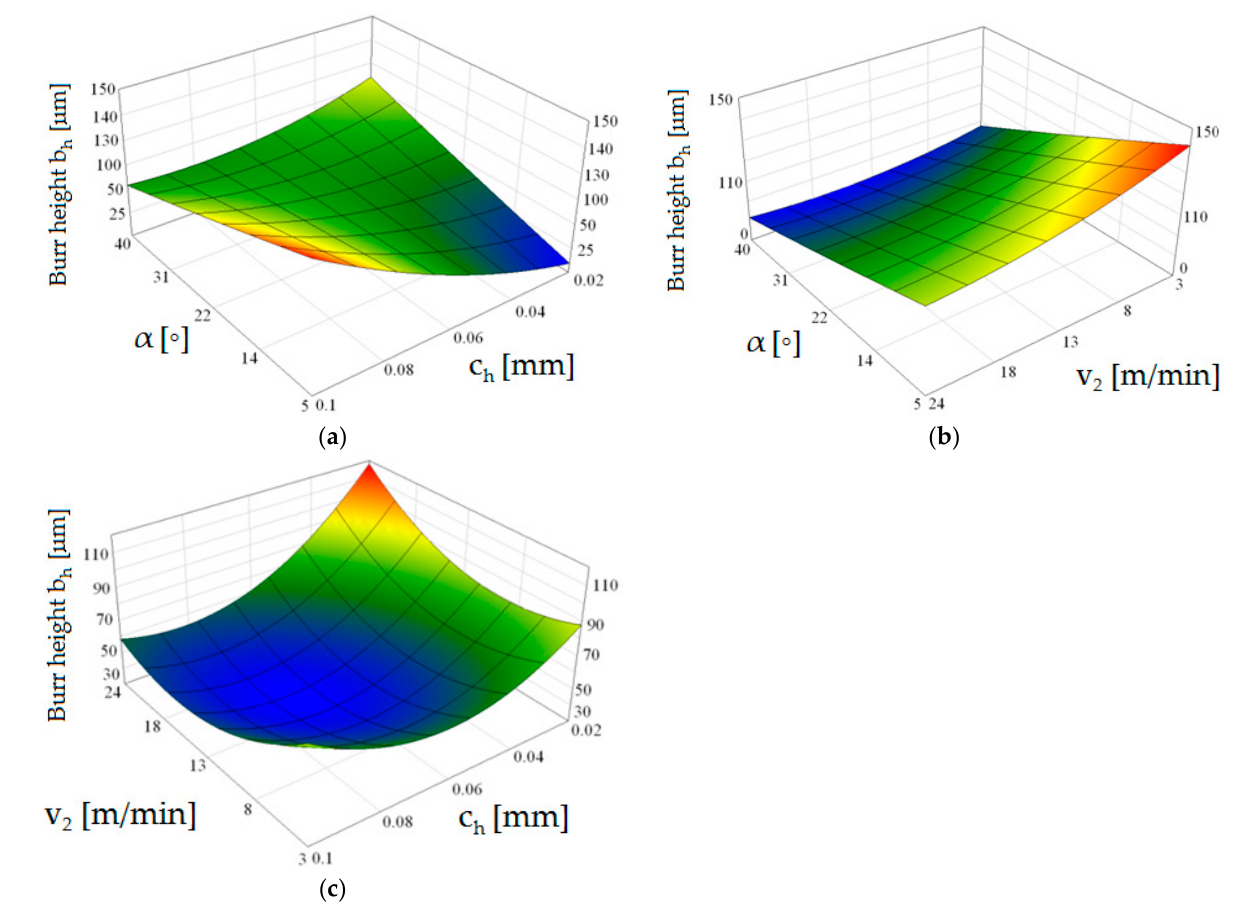
Figure 12. Graphs of the dependence of the burr height on the selected process parameters ( a – c ).